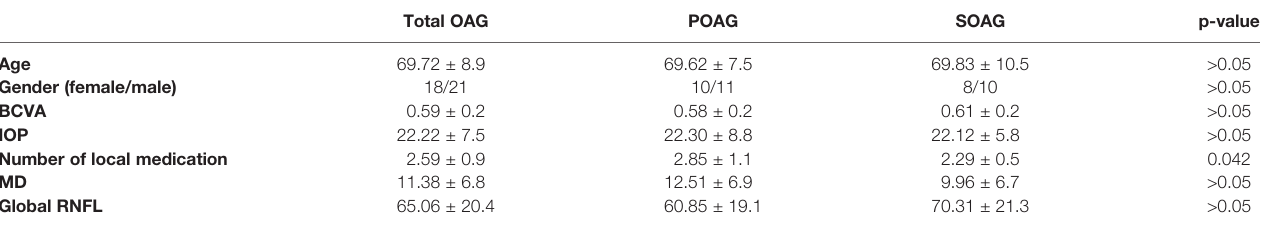
TABLE 1 | Demographic data: age, gender, best corrected visual acuity (BCVA), intraocular pressure (IOP, mmHg), number of local antiglaucomatous eye drops, mean defect (MD) and global retinal nerve fi ber layer (gRFNL, µm) for open-angle glaucoma (OAG), primary OAG (POAG) and secondary OAG patients (SOAG); mean ± standard deviation,